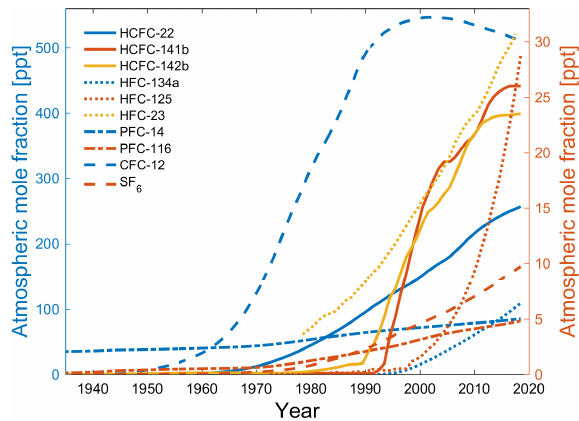
Figure 5. Atmospheric histories of HCFC-22, HCFC-141b, HCFC- 142b, HFC-134a, HFC-125, HFC-23, PFC-14, PFC-116, CFC-12, and SF 6 in the Northern Hemisphere. HCFC-22, HFC-134a, PFC- 14, and CFC-12 share the left y -axis scale; other compounds share the right y -axis